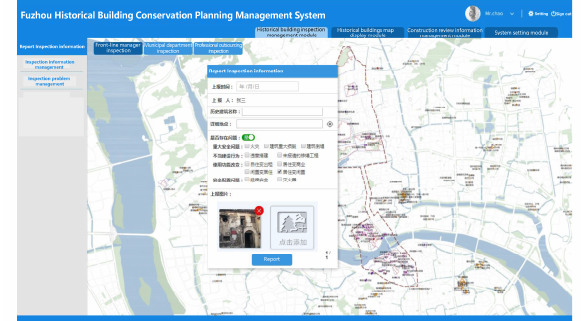
Figure 3. Inspection information reporting